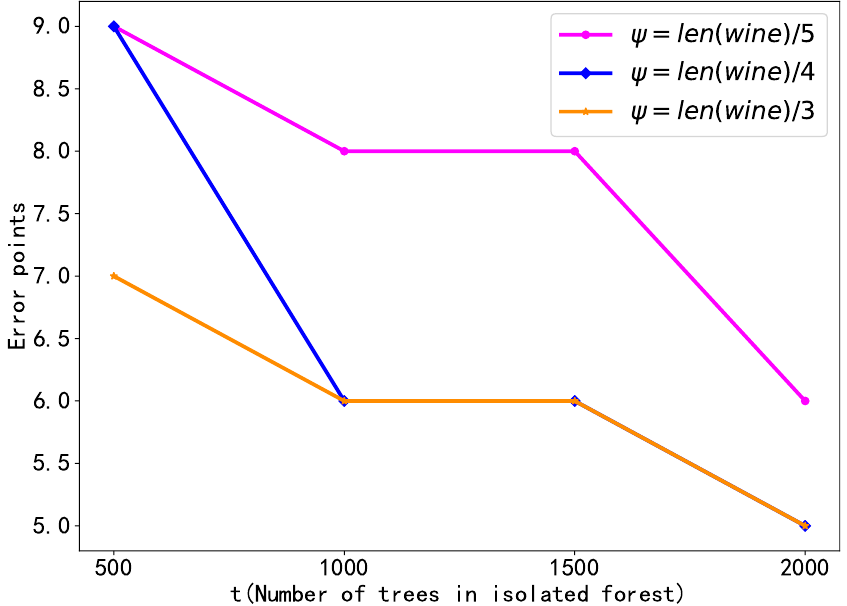
Figure 8. Influence of own parameters on experimental